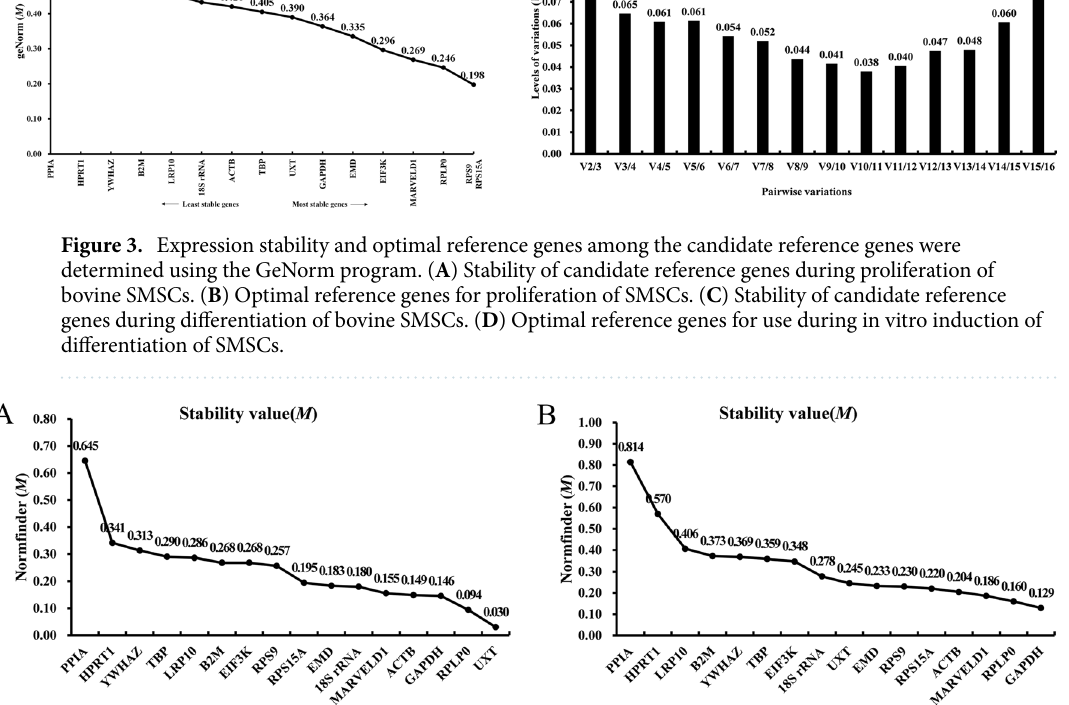
Figure 4. Expression stability of candidate reference genes as analyzed using the NormFinder program. ( A ) Stability of candidate reference genes in bovine SMSCs during proliferation. ( B ) Stability of candidate reference genes in induced differentiation of bovine